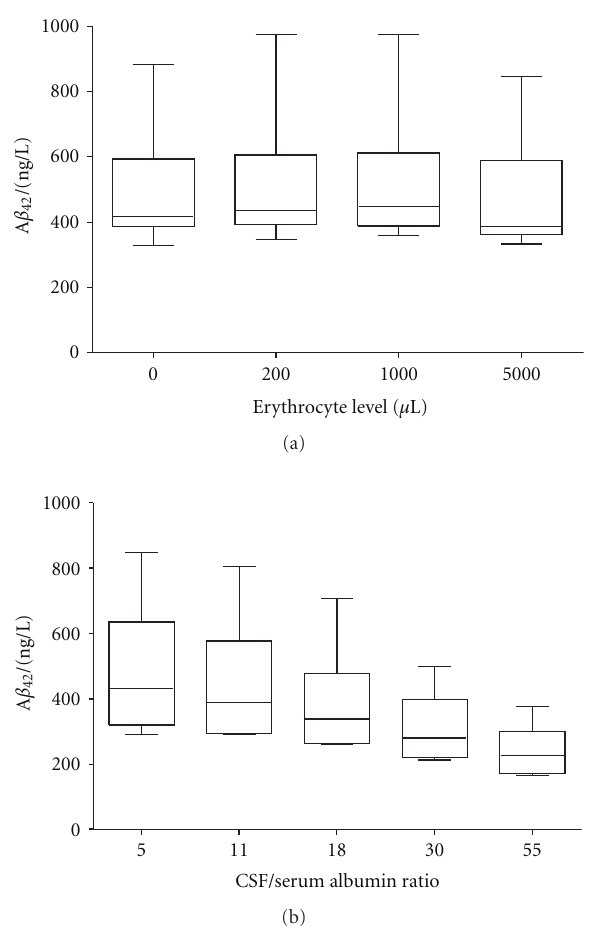
Figure 2: Boxplots with whiskers representing minutes and max values. (a) The e ff ect of blood contamination on CSF A β 42 levels. The addition of blood to CSF representing an erythrocyte level of 200, 1000 and 5000 / μ L of blood did not a ff ect the A β 42 level compared with neat CSF. (b) The e ff ect a blood-brain barrier dysfunction on A β 42 levels. Plasma was added to CSF at a concentration representing a CSF/serum albumin ratio of 11, 18, 30 and 55. The A β 42 concentration was significantly decreased ( P < . 01) at all added plasma concentrations.